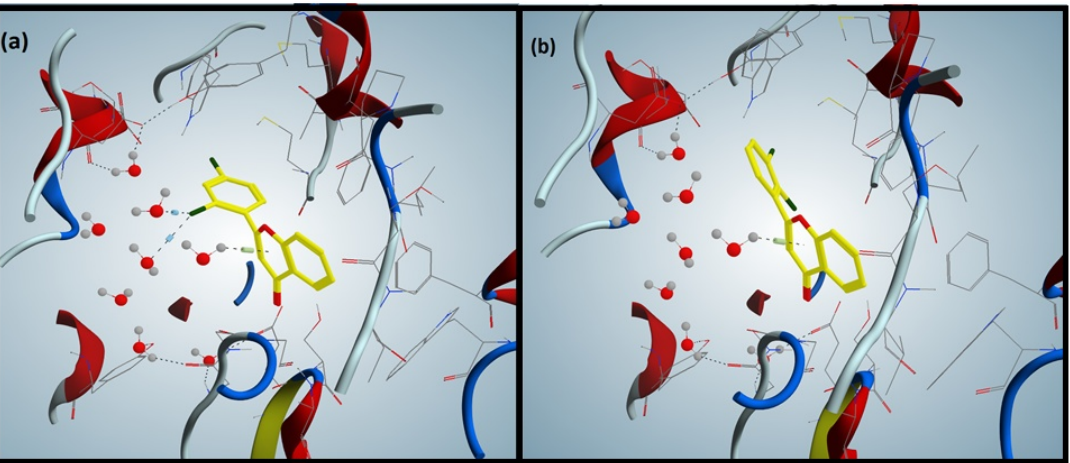
Figure 2. ( a ) shows the docking interactions of the most active compound, F2. ( b ) shows the inter- action of the least active compound, F3